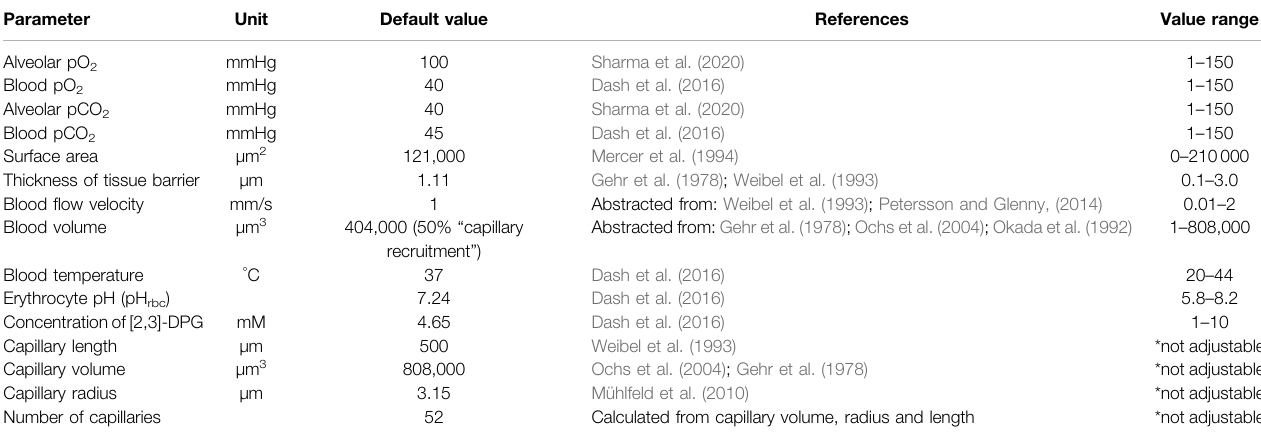
TABLE 1 | Model parameters and their default values. Values of morphological and physiological parameters of the gas exchange model were collected from literature. All values given are mean values referring to a single alveolus. Parameter Unit Default value Alveolar pO